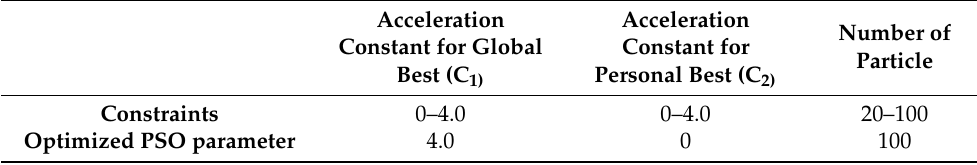
Figure 5. Interaction effects of PSO parameters against fitness value. Table 3. Results of optimization of PSO